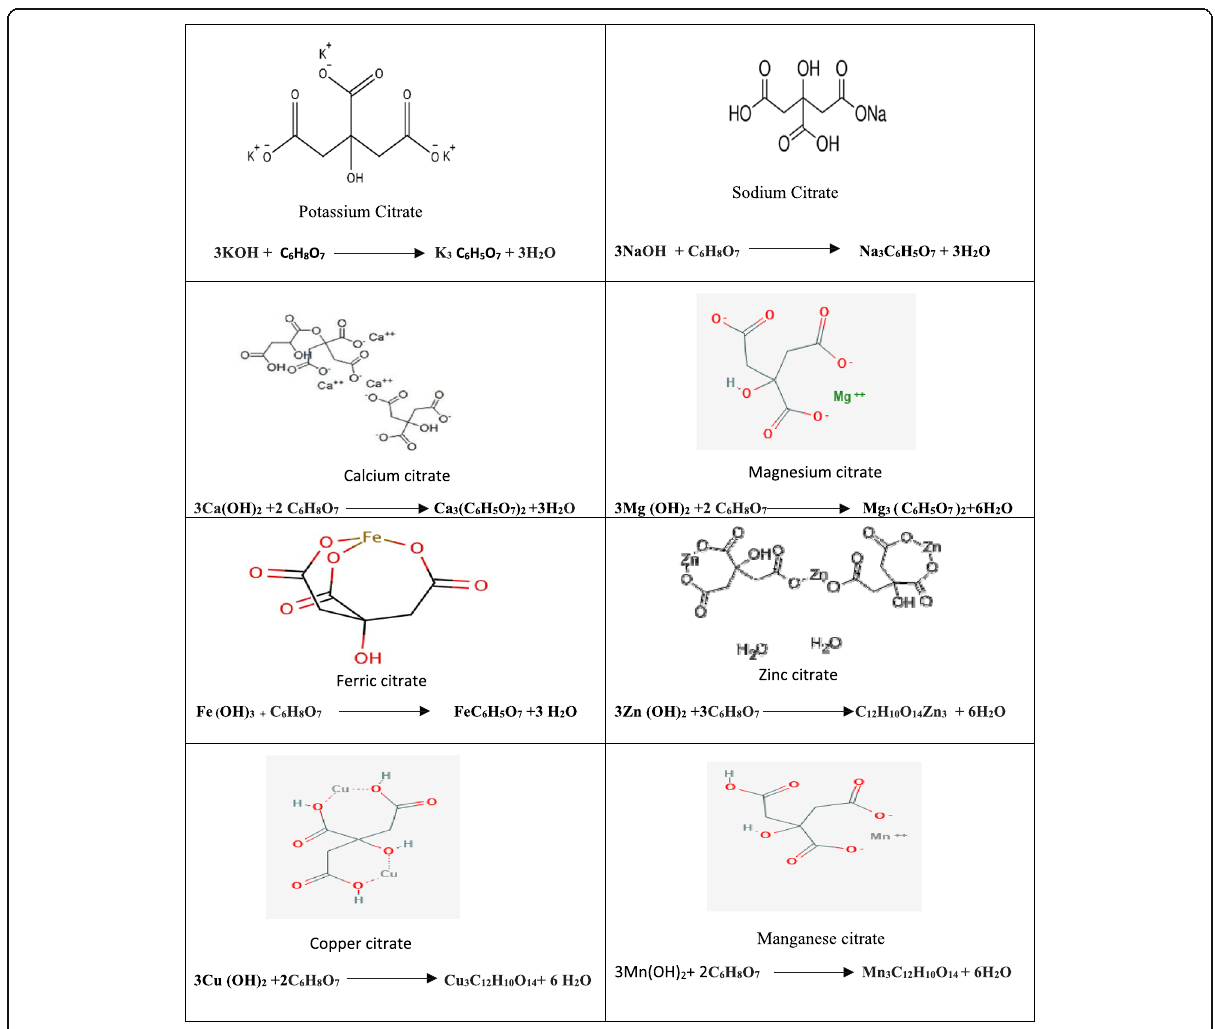
Fig. 6 Chemical equation and mechanism of elements of banana peel with citric